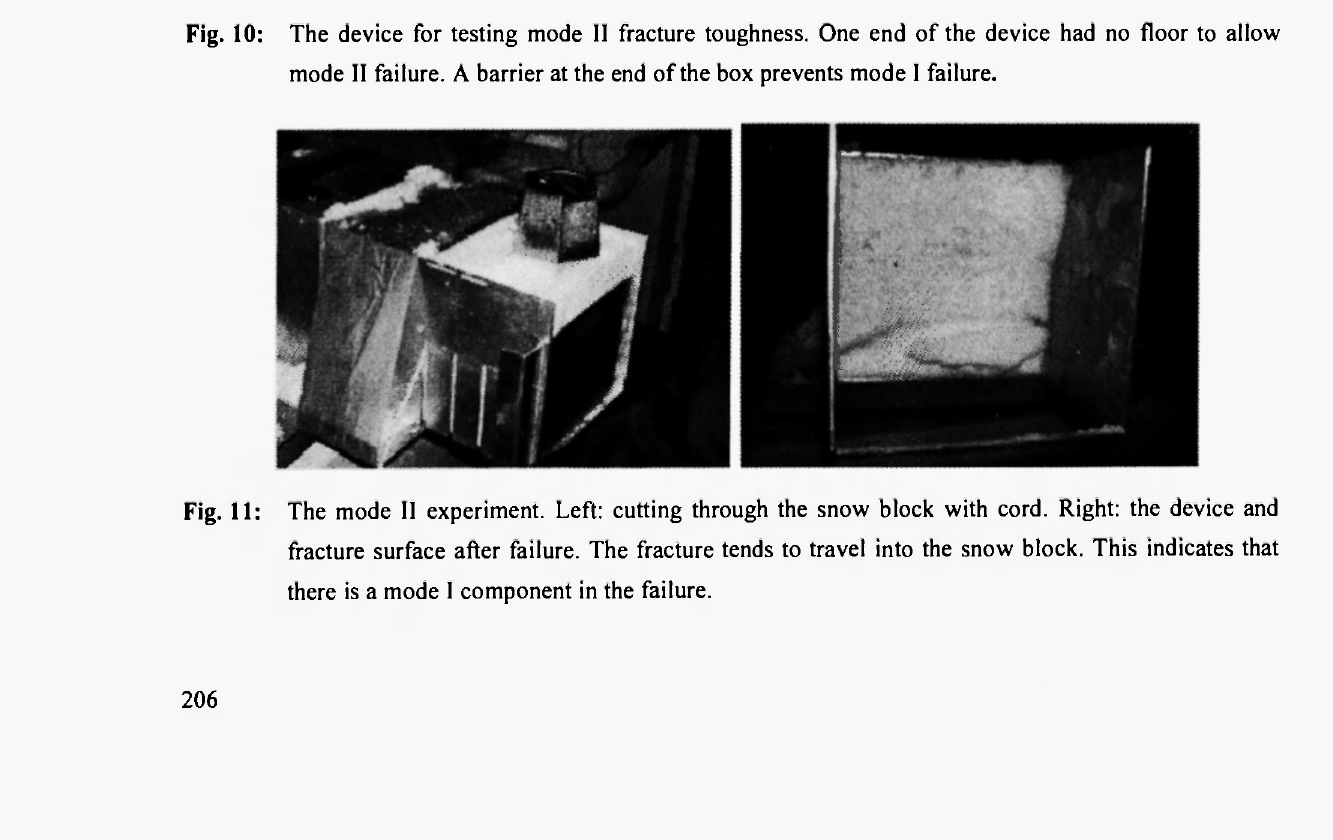
Fig. 11: The mode II experiment. Left: cutting through the snow block with cord. Right: the device and fracture surface after failure. The fracture tends to travel into the snow block. This indicates that there is a mode I component in the